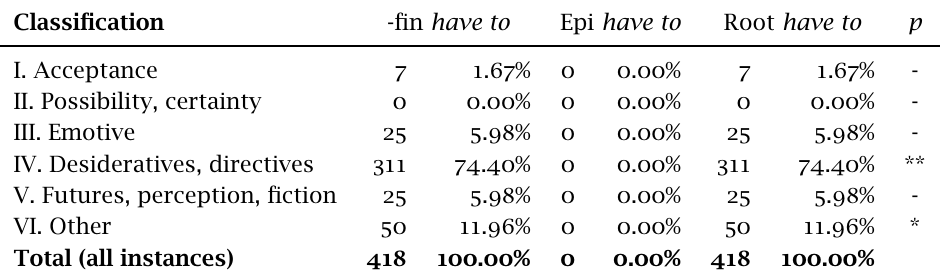
Distribution of have to in infinitival complements of attitude verbs: ** p < epistemic and root have to in each class to the distribution of this semi-modal in matrix